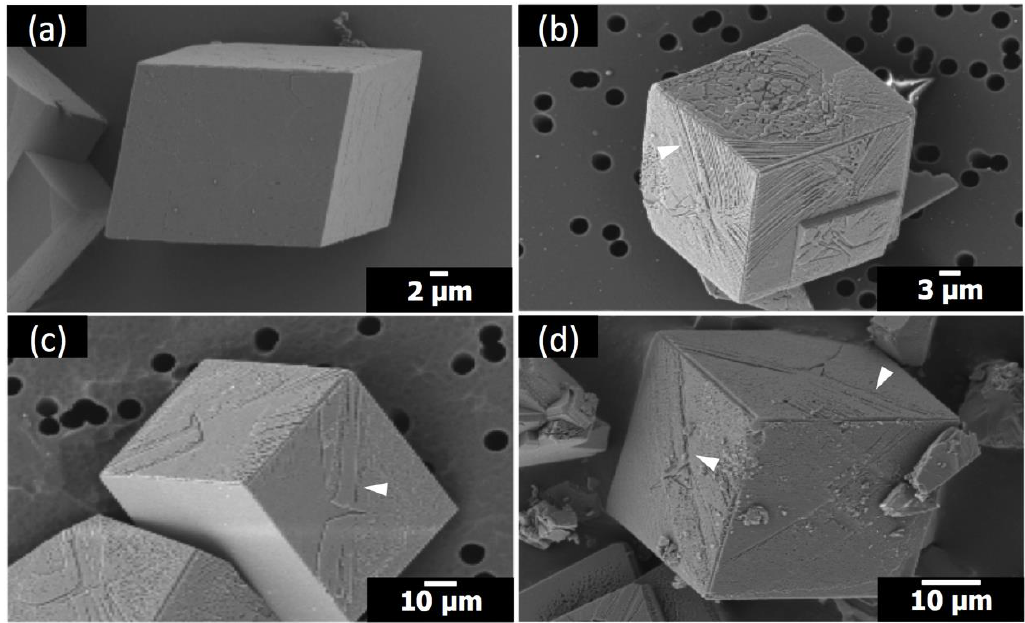
Figure 3. SEM images of the calcite crystals formed with: ( a ) no additives; ( b ) 1 µ M PAA at Sr / Ca = 1:100; ( c ) 1 µ M PAA at Sr / Ca = 1:50; ( d ) 1 µ M PAA at Sr / Ca = 1:25.